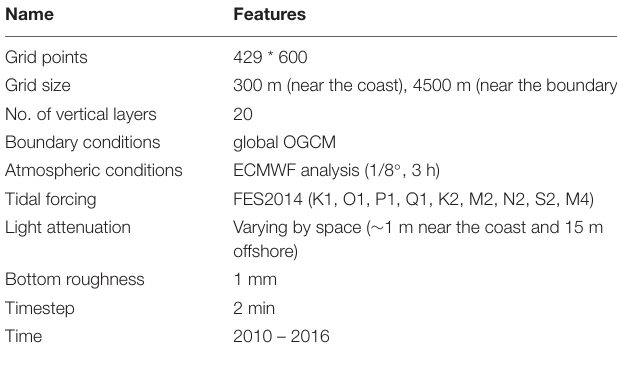
TABLE 1 | General characteristics of